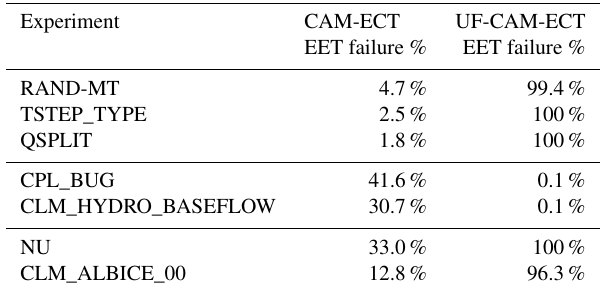
Table 3. These experiments represent disagreement between UF- CAM-ECT and fail CAM-ECT. Shown are the EET failure rates from 30